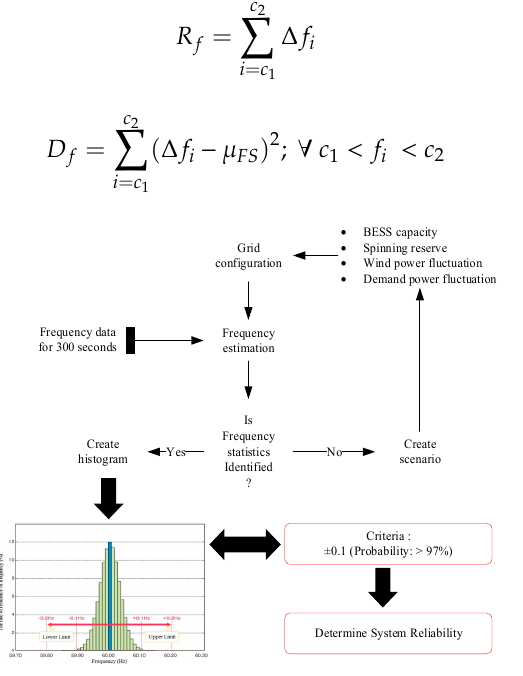
Figure 7. Reliability criteria selection.